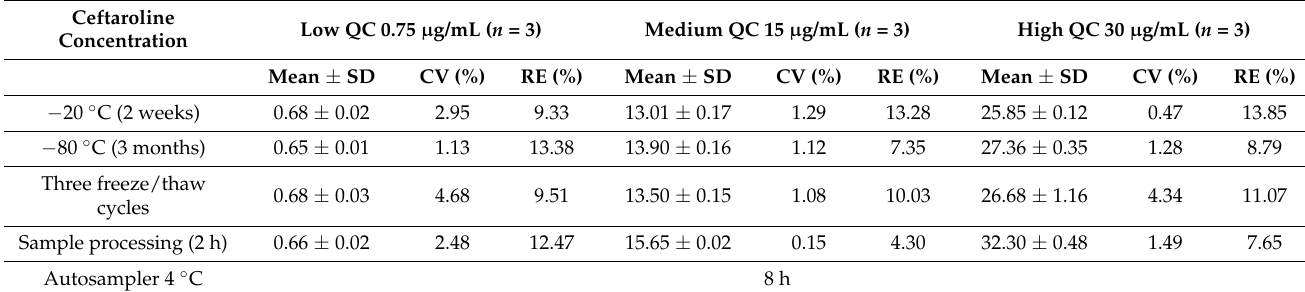
Table 5. Stability of ceftaroline in plasma under different conditions.